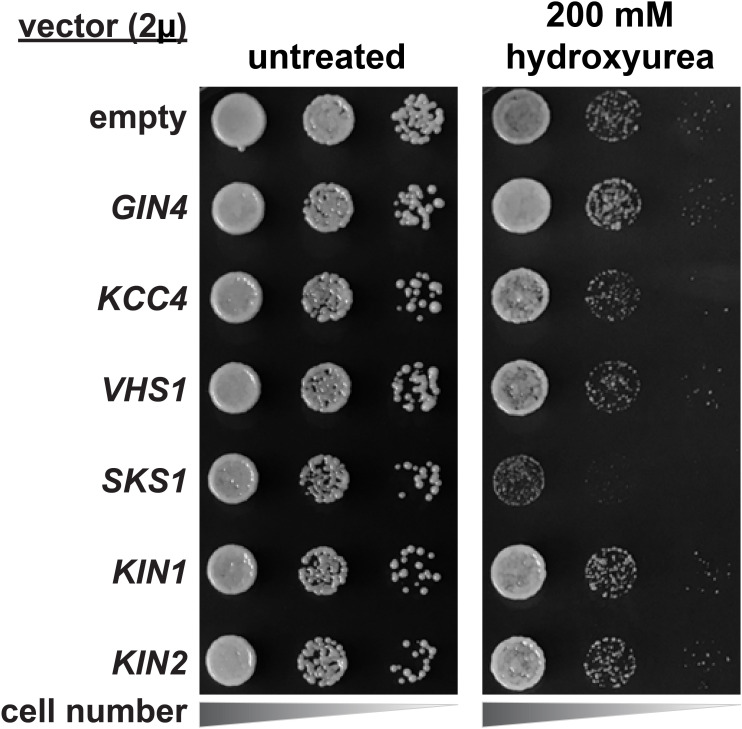
Hydroxyurea growth phenotype of yeast strains overexpressing Ser57 ubiquitin kinases.SUB280 cells harboring the indicated kinases (expressed from the 2µ multicopy plasmid pRS327) were serially diluted onto lysine-dropout synthetic media or equivalent media supplemented with 200 mM hydroxyurea and grown at 26°C. KIN1 and KIN2 were included as control kinases in the Snf1-related family that did not exhibit Ser57 ubiquitin kinase activity in our screening (Figure 3—figure supplement 2).